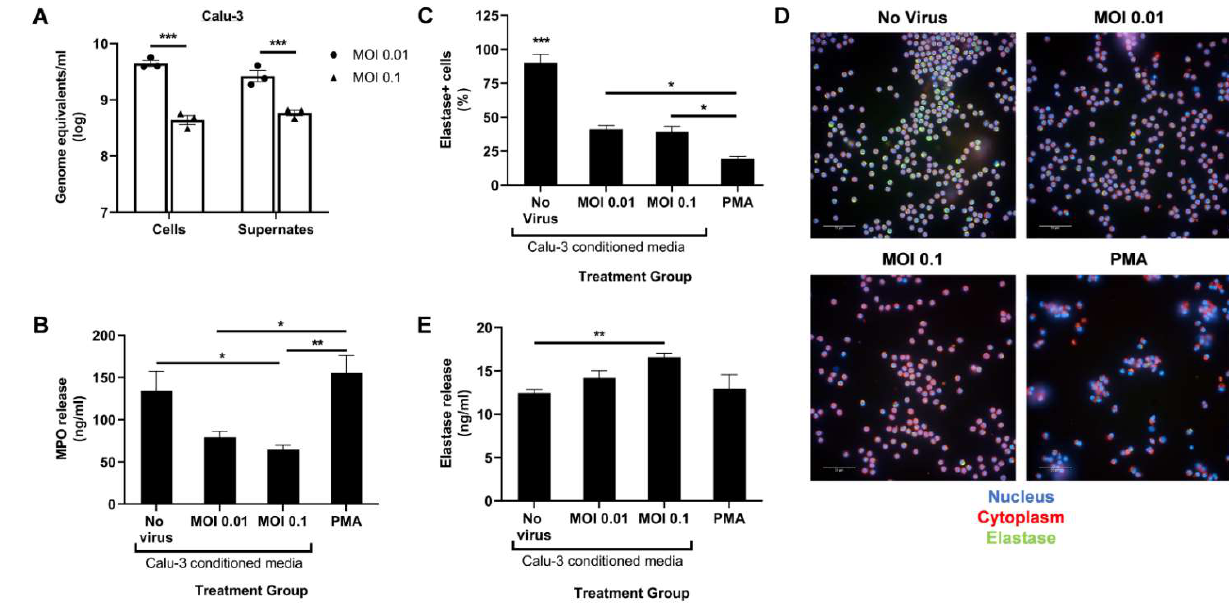
Figure 1. SARS-CoV-2-infected Calu-3 cells secrete factors that diminish neutrophil MPO release. ( A ) Viral titer in the cells and supernates of SARS-CoV-2-infected Calu-3 48 h post infection; UV- irradiated Calu-3 supernates, referred to as Calu-3-conditioned media, were used to treat human neutrophils. ( B ) MPO levels in the treated neutrophils supernatant media determined through ELISA; ( C ) Percentage of neutrophil elastase-positive cells among total cells; ( D ) Representative images at 40 × magnification of neutrophils stained for their nucleus (blue), cytoplasm (red), and neutrophil elastase (green); ( E ) Neutrophil elastase levels in the treated neutrophils supernatant media determined through ELISA. Data shown are mean ± SEM; n = 3 per group in each experiment per donor; experiments were repeated twice with two different donors; * p < 0.05, ** p < 0.01, *** p < 0.001 (one-way ANOVA with Tukey’s post hoc test).